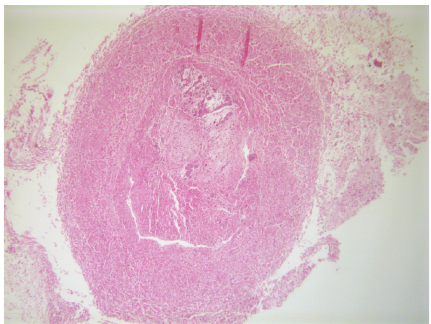
Figure 4: Cross section of the left renal vein showing occlusion by precalcified fibrosis, confirming that the thrombosis took place